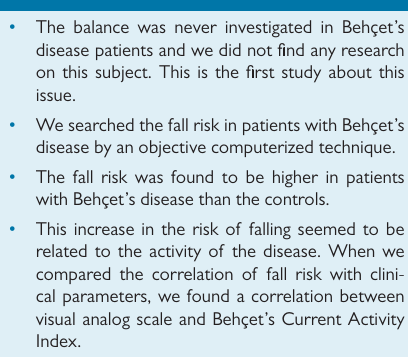
Table 2. The Behçet’s Current Activity Indices of the patients was 4.17 ± 1.99 (mean ±